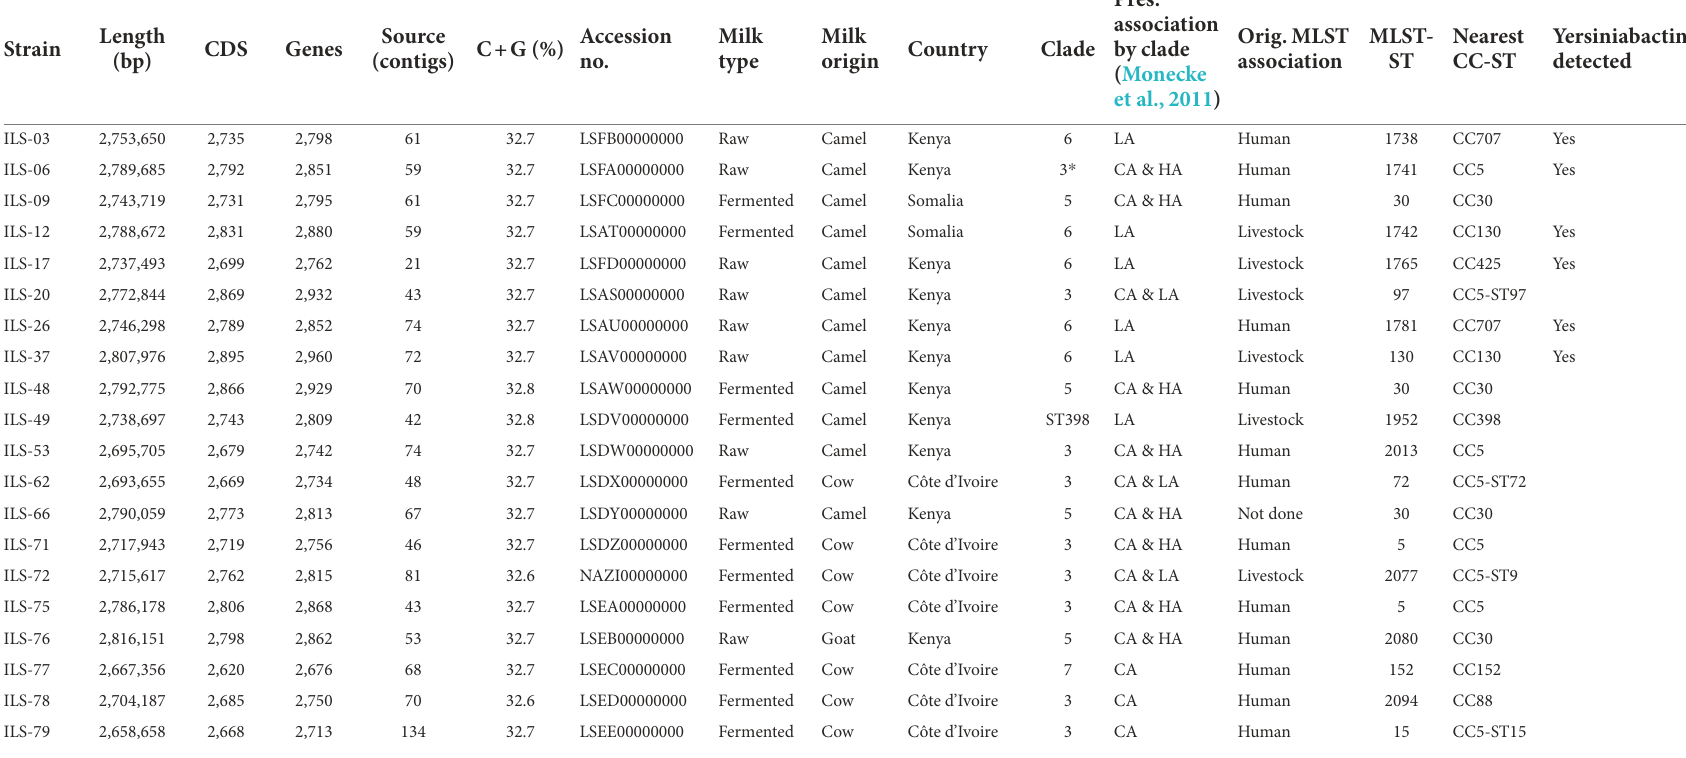
TABLE 1 Genome statistics of Staphylococcus aureus strains of African dairy sources obtained and characterized in this study (genome sequences available under BioProject PRJNA310553 on GenBank).